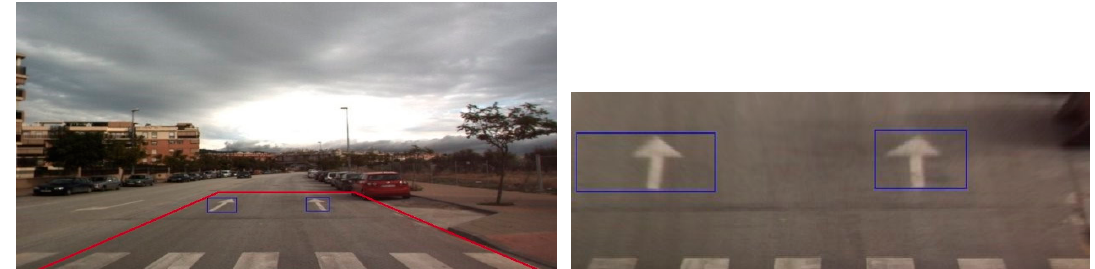
Figure 14. Examples of the original ( left image) and its corresponding IPM images ( right image).